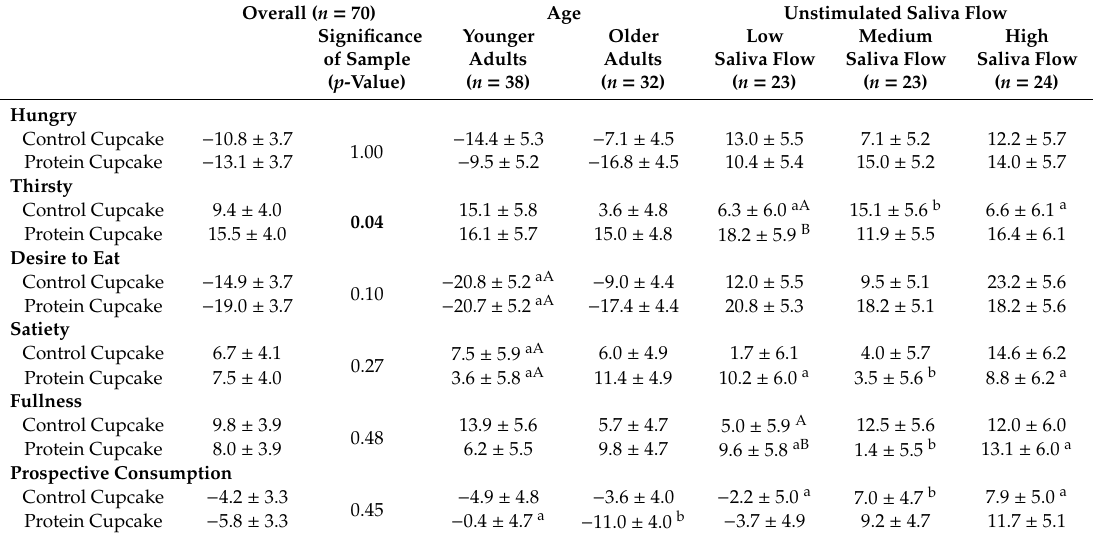
Table 9. Volunteers’ appetite mean ratings (change from baseline) of cupcakes in the main study; overall and by age and unstimulated saliva flow rate.